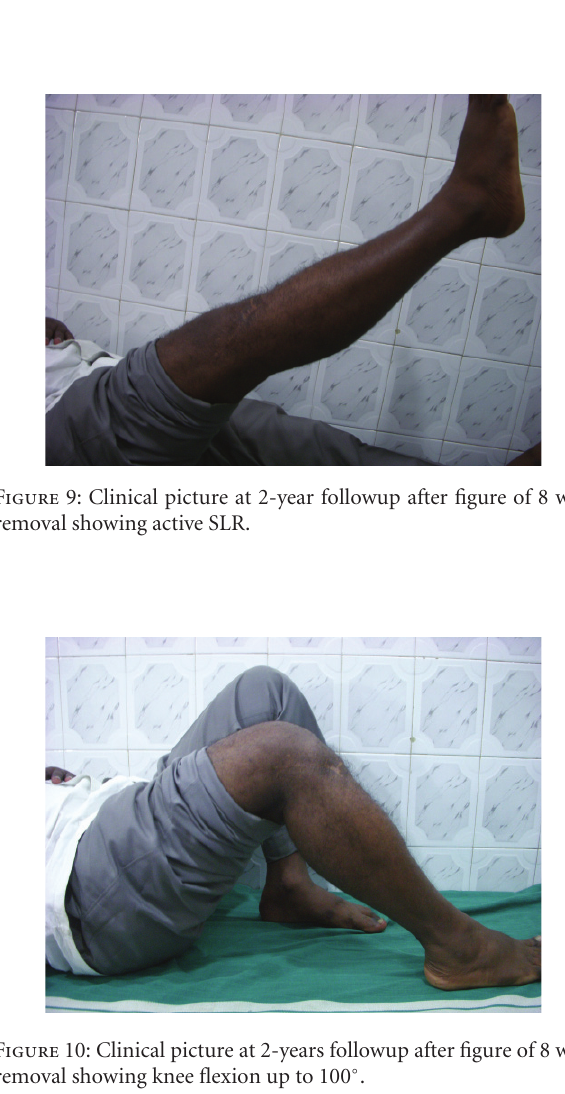
Figure 8: X-ray right leg AP and lateral views at 2-year followup showing fracture union.